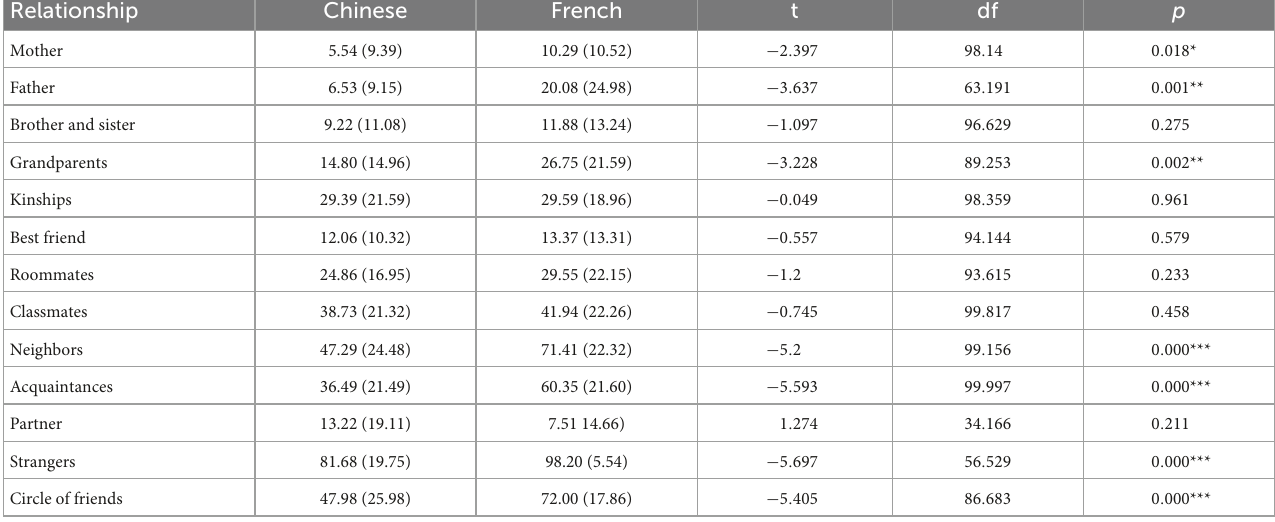
TABLE 1 Mean perceived social distance in the self-representation task. Relationship